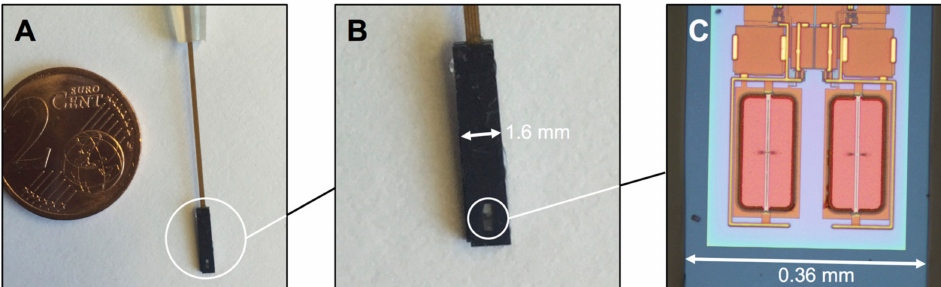
Figure 6. ( A ) Sensor probe (white circle); ( B ) Magnification of the sensor probe showing the cooling body, cover plate and semipermeable membrane; ( C ) Optical microscope picture of the micro-electromechanical system (MEMS) part of the sensor chip prior to integrating the semipermeable membrane and filling with the affinity assay. The measurement MEMS is given on the left and the reference MEMS is provided on the right-hand side of the figure. Golden-coloured cantilevers can be seen to stretch over the ground plates (orange-brown) in both cases. Due to the architecture of the semiconductor layer stack, the cantilevers have a height of 2.5 µ m above the ground plate, such that the configuration of both forms a kind of parallel plate